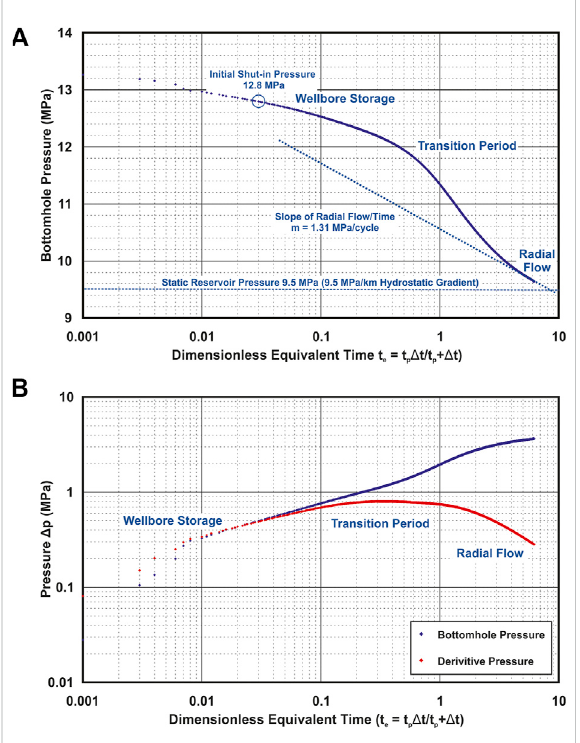
FIGURE 9 Pressure transientanalysis of thestep-rate testdata. (A) . Log- log plot of bottomhole falloff pressure delta-p (dp) plotted against Agarwal dimensionless equivalent time (Agarwal, 1979, 1980). The wellbore entered radial fl ow shortly after falloff pressure monitoring began, as shown in Bowersox et al. (2021, Figure 11). Test interval permeability calculated from the pressure falloff data was 75.5 mD with a − 3.59 skin factor indicative of wellbore fl ow enhancement by hydraulic fracturing, consistent with the step- rate test response. (B) Derivative pressure (dp/dt) plotted against Agarwal dimensionless equivalent time. Pressure-gauge data have been resampled at fi ve-reading intervals to reduce noise in the data. The wellbore entered radial fl ow about 0.5 h after shut-in. The pressure derivative curve suggests the Rose Run in the KGS